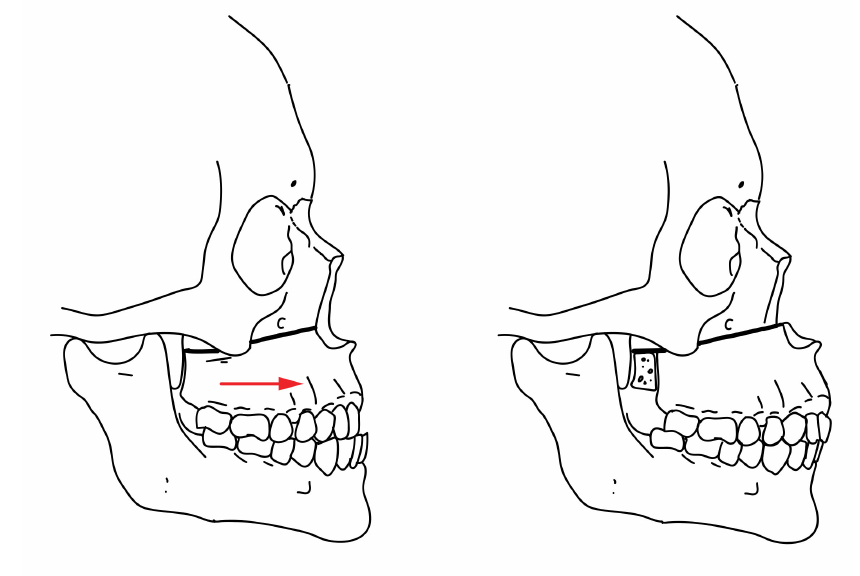
Figure 4. Schematic view of Le Fort I osteotomy.